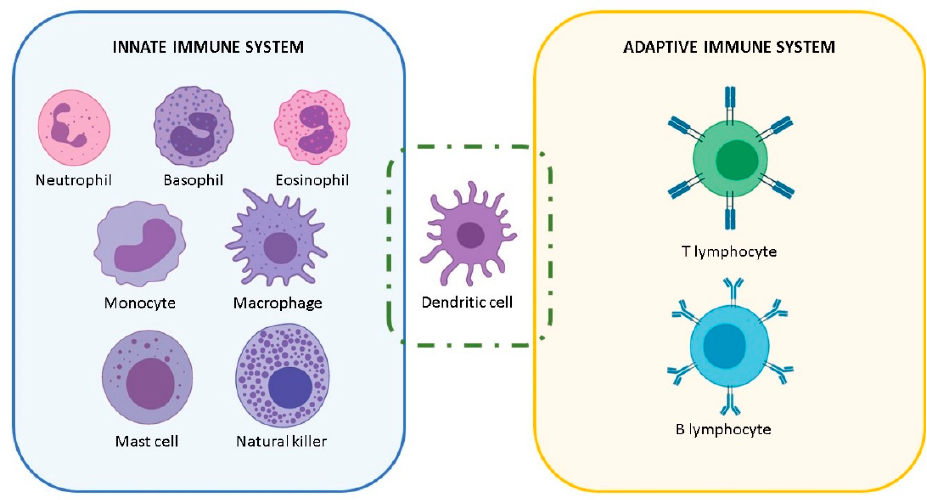
Figure 1. Representative classification of the most common mammalian immune cells.